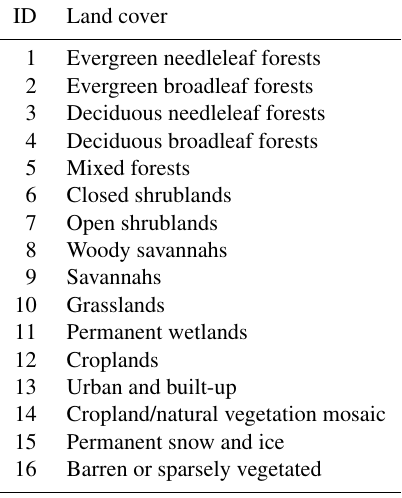
Table A2. Classification of land cover in ISLSCPII (see Table